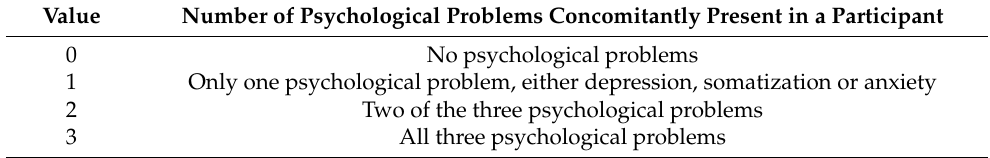
Table 1. The value of the number of psychological problems concomitantly present in a participant.